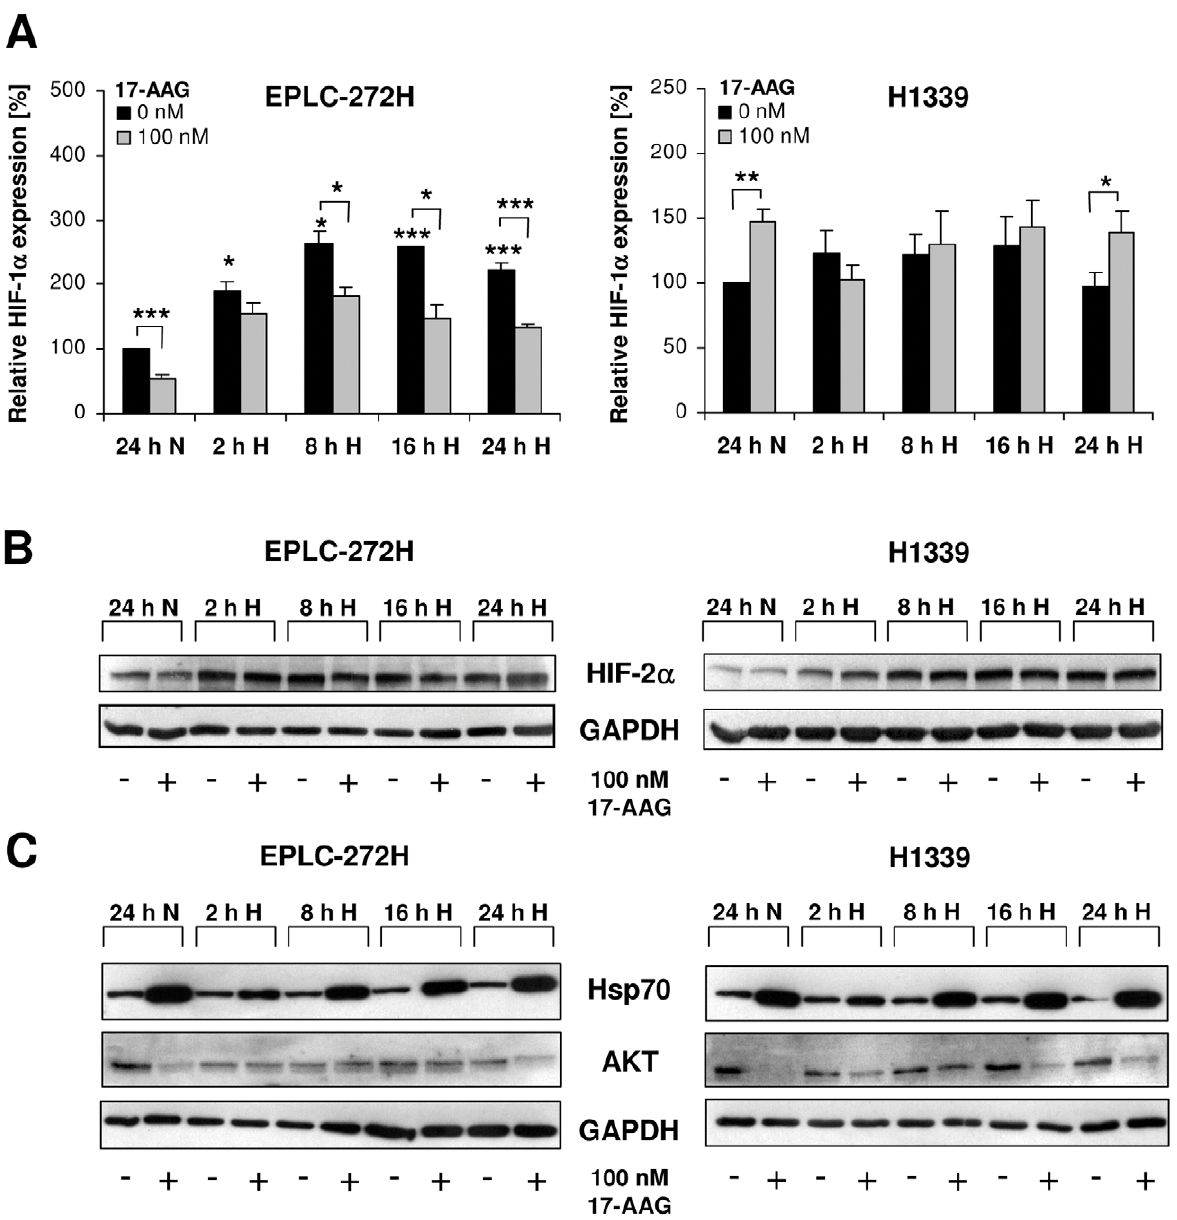
Figure 1. Time kinetics of HIF-1 a , HIF-2 a and Hsp70 levels after treatment with 17-AAG and exposure to hypoxia. (A) HIF-1 a expression levels in EPLC-272H (left panel) and H1339 (right panel) cells treated with 17-AAG and subsequently (30 min later) exposed to normoxia for 24 h (24 h N) or hypoxia for 2 h (2 h H), 8 h (8 h H), 16 h (16 h H) and 24 h (24 h H) were determined by ELISA. Mean values 6 SEM of at least three independent experiments are shown. * p # 0.05, ** p # 0.01, *** p # 0.001. (B and C) Representative HIF-2 a (B), Hsp70 and AKT (C) immunoblots of EPLC-272H and H1339 cells treated with 17-AAG and subsequently (30 min later) exposed to normoxia for 24 h (24 h N) or hypoxia for 2 h (2 h H), 8 h (8 h H), 16 h (16 h H) and 24 h (24 h